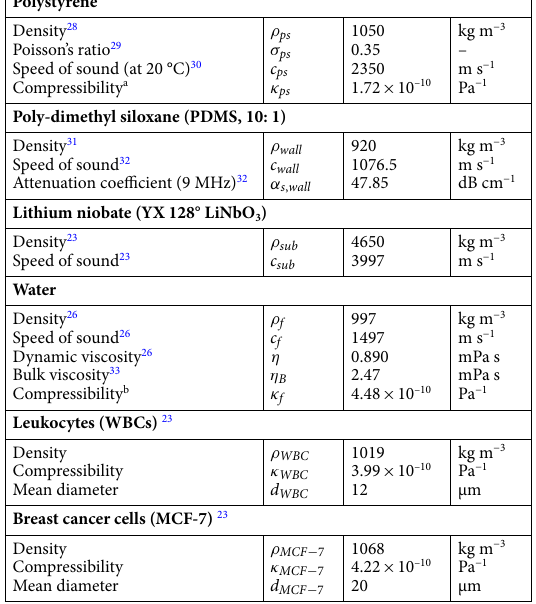
Table 1. Material parameters (at T = 25 °C). a Calculated from Landau and Lifshitz as κ ps = b Calculated as κ 0 = 1